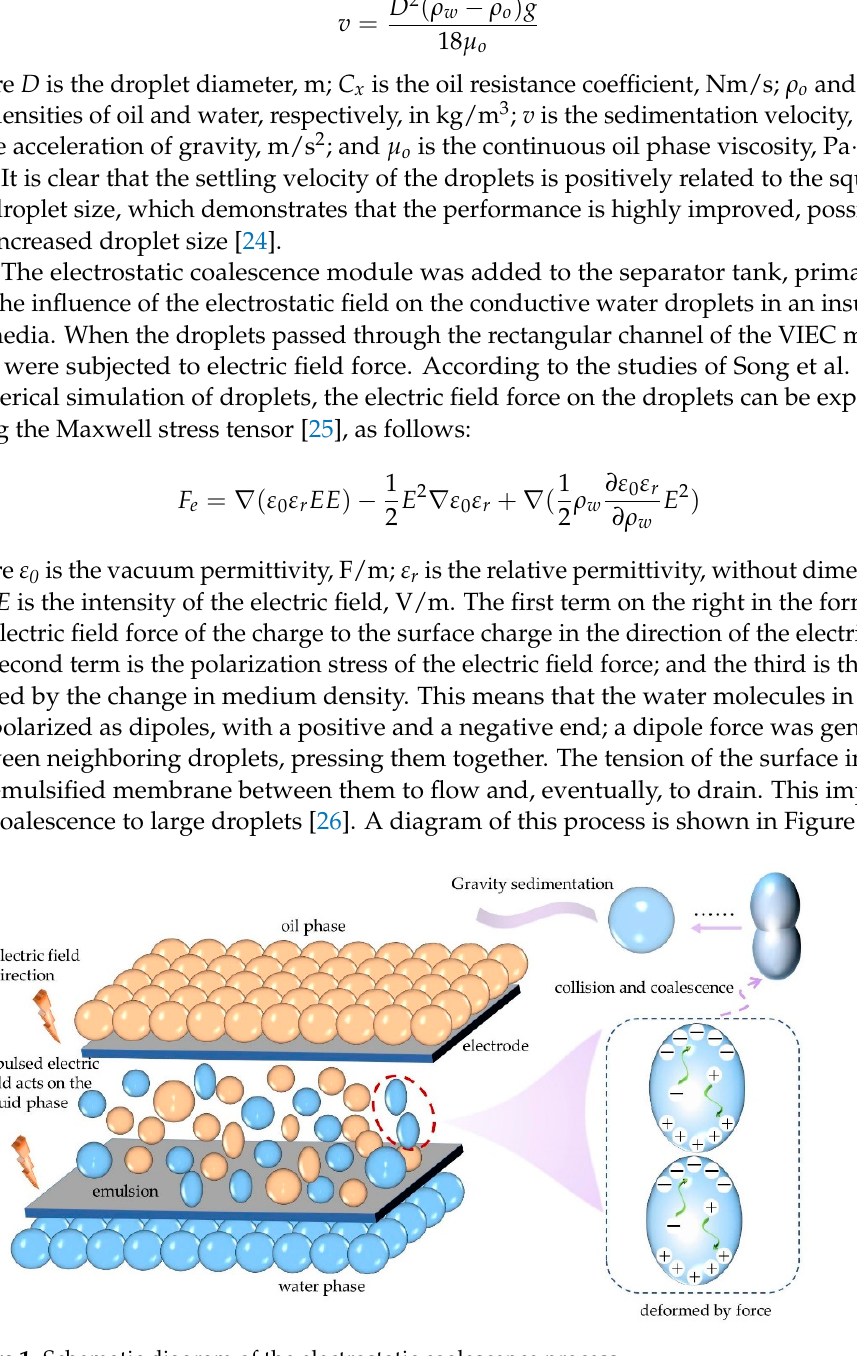
Figure 1. Schematic diagram of the electrostatic coalescence process.